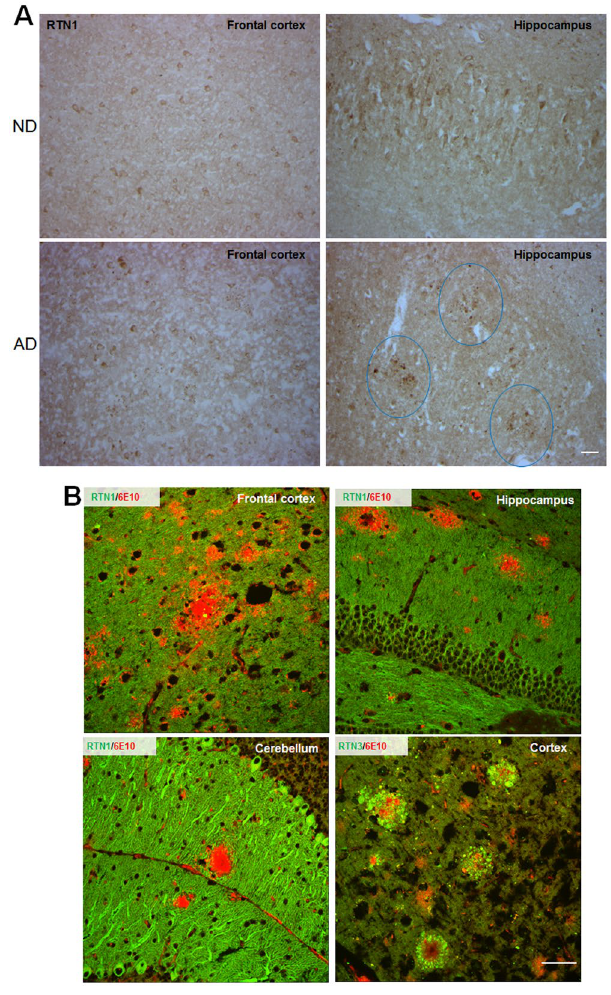
Figure 5. RTN1 and RTN3 differentially label dystrophic neurites in AD brains. ( A ) Brain sections from postmortem human (AD) or non-demented (ND) brains were labeled by antibody R418 in immunohistochemical staining. Strong neuronal expression of RTN1 was detected in ND samples. In AD brains, RTN1 appeared to be enriched in areas with amyloid plaques (circled). ( B ) Fixed brain samples from six-month-old Tg-APPswe/PSEN1 Δ E9 mouse brains were detected by R418 for RTN1 (green), R458 for RTN3 (green), and 6E10 for amyloid plaques (red). Amyloid plaques from different brain regions, including the cerebellum, were selected. Unlike RTN3, RTN1 was weakly enriched in dystrophic neurites. Processes labeled by RTN1 were more evident than those labeled by RTN3. Scale bar is 30 µ